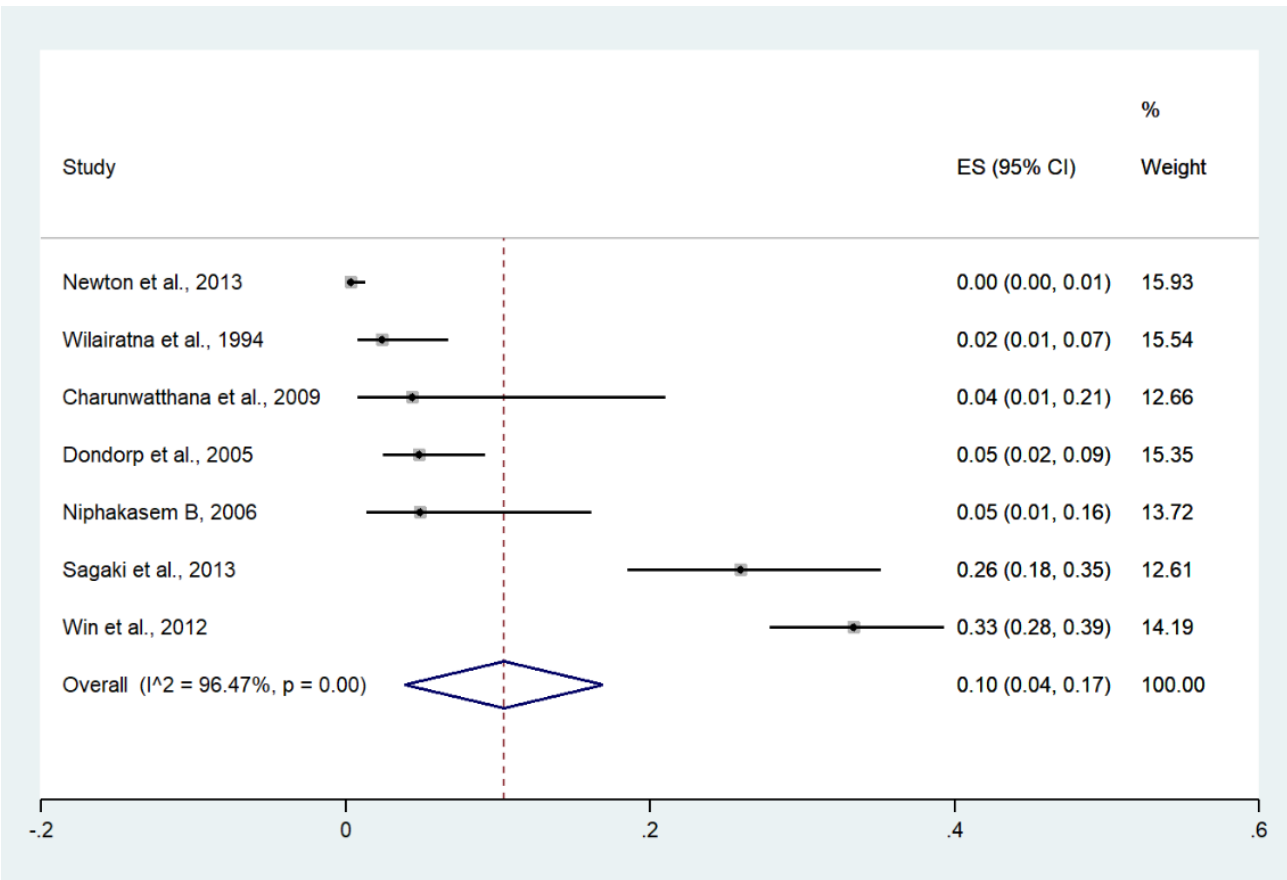
Figure 14. The pooled prevalence of shock among patients with severe malaria in Thailand. The label for the x-axis is the scale of estimated prevalence. Abbreviations; ES, estimated prevalence; CI, confidence interval .